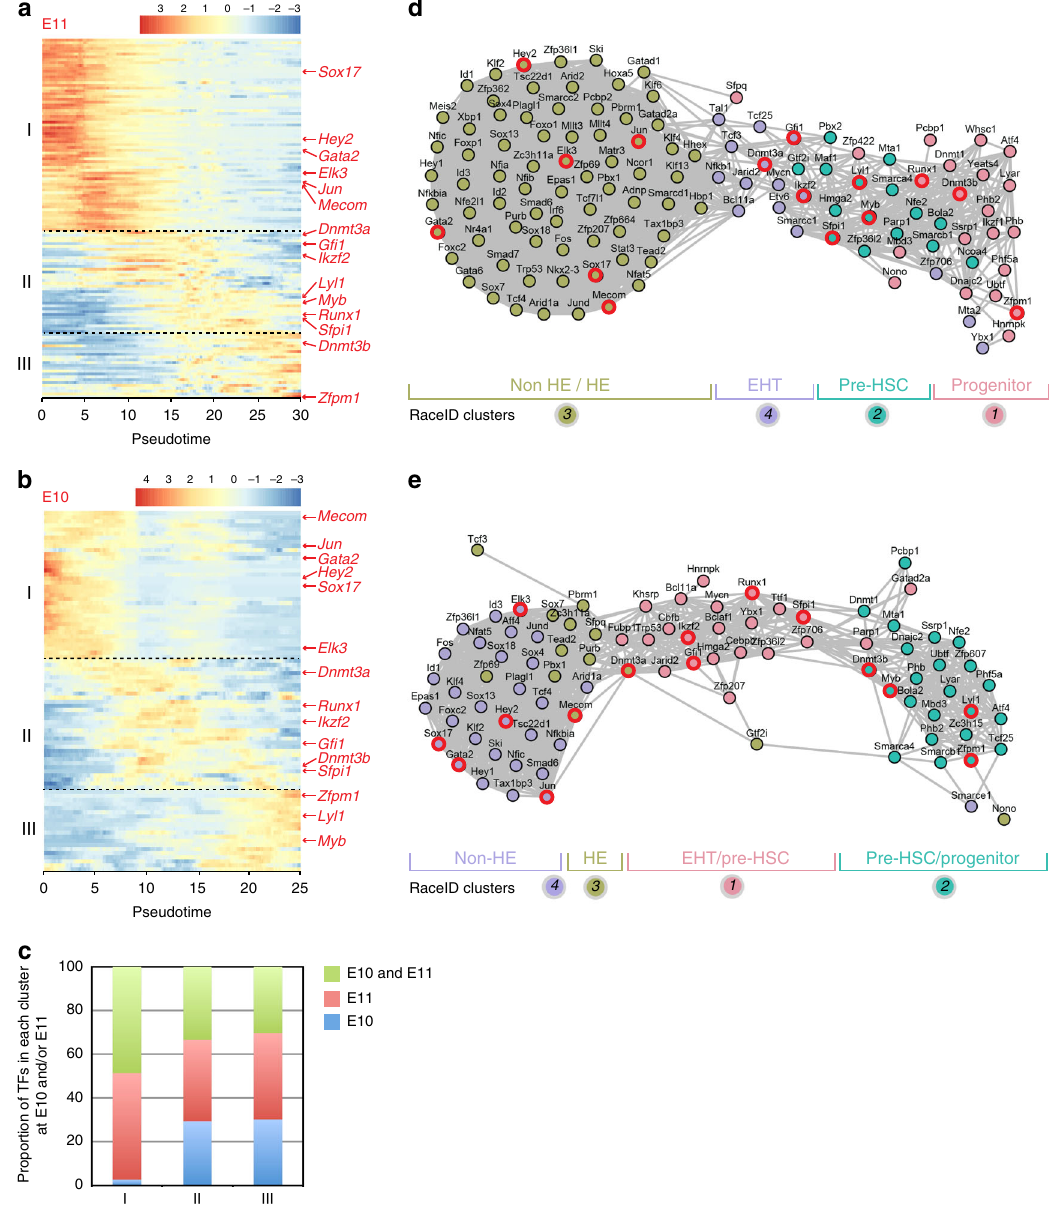
Fig. 4 Transcription factor networks involved during IAHC formation at E11 and E10. a , b Heatmap of differentially expressed transcription factors (TFs) at a E11 and b E10 between the different cell types (non-HE, HE, EHT, IAHC cells, and YS HSPCs), according to pseudotime. Three distinct expression patterns are identi fi ed as clusters I, II, and III. c Proportion of transcription factors that are present in clusters I, II, or III at both E10 and E11, only at E11 or only at E10. d , e Network of TFs related to different expression patterns as determined in a and b , respectively. Color-coded circles are related to RaceID analysis shown in Figs. 2d and 3c, respectively. TFs mentioned in the results section are outlined in